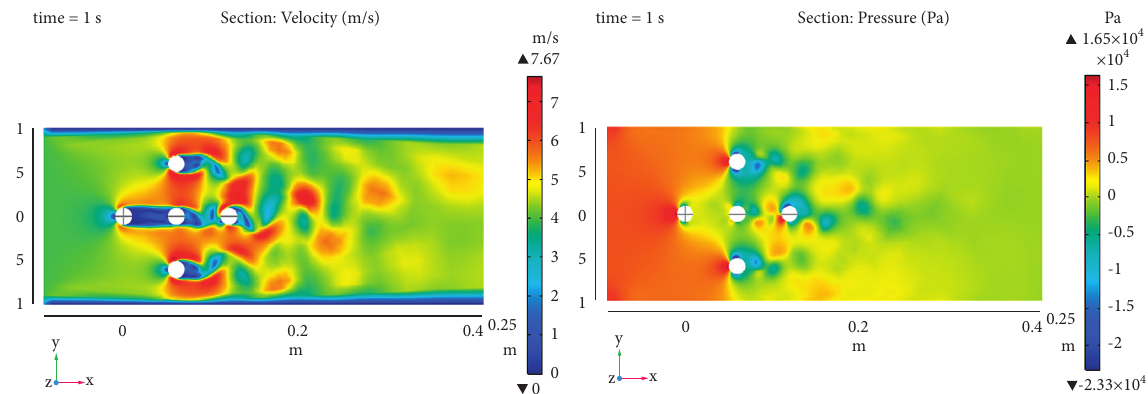
Section: Pressure (Pa)time = 1 sSection: Velocity (m/s)time = 1 s